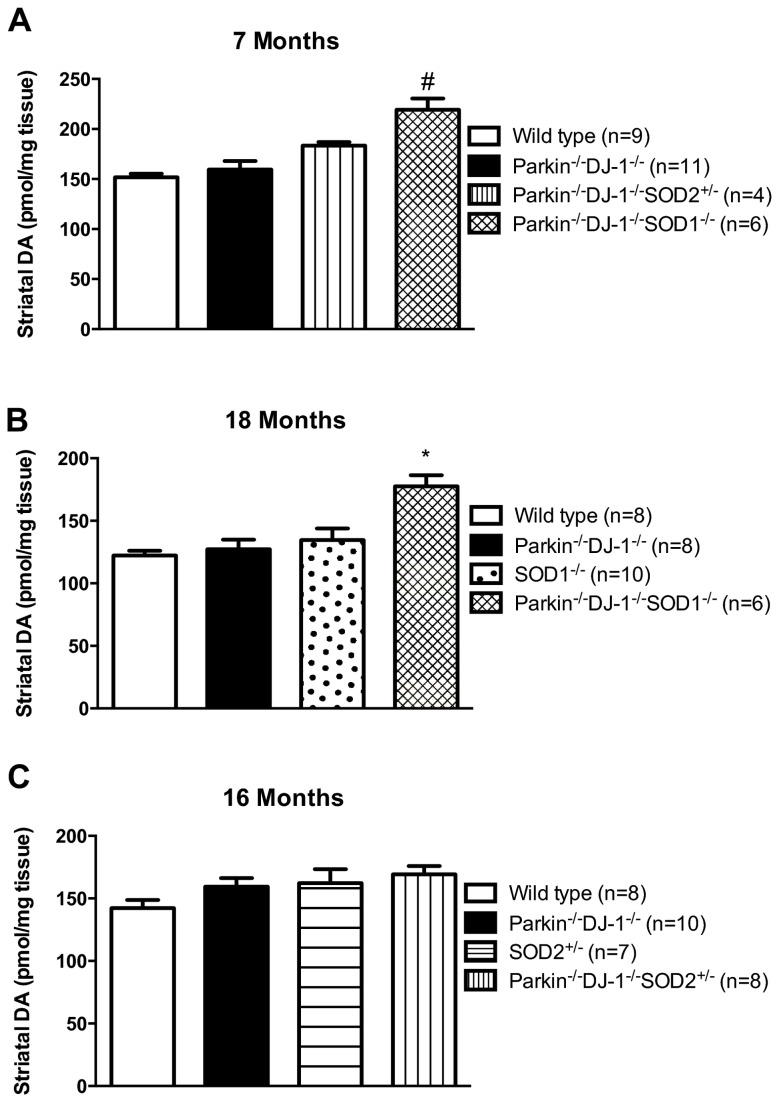
Dopamine levels are elevated in Parkin-/-DJ-1-/-SOD1-/- mice.Total dopamine levels were measured by HPLC analysis in separate cohorts of mice ages 7 (A), 18 (B) and 16 (C) months (n ≥ 6). (*p ≤ 0.001 by one way ANOVA; #p<0.001 by Kruskal-Wallis one way ANOVA on ranks).